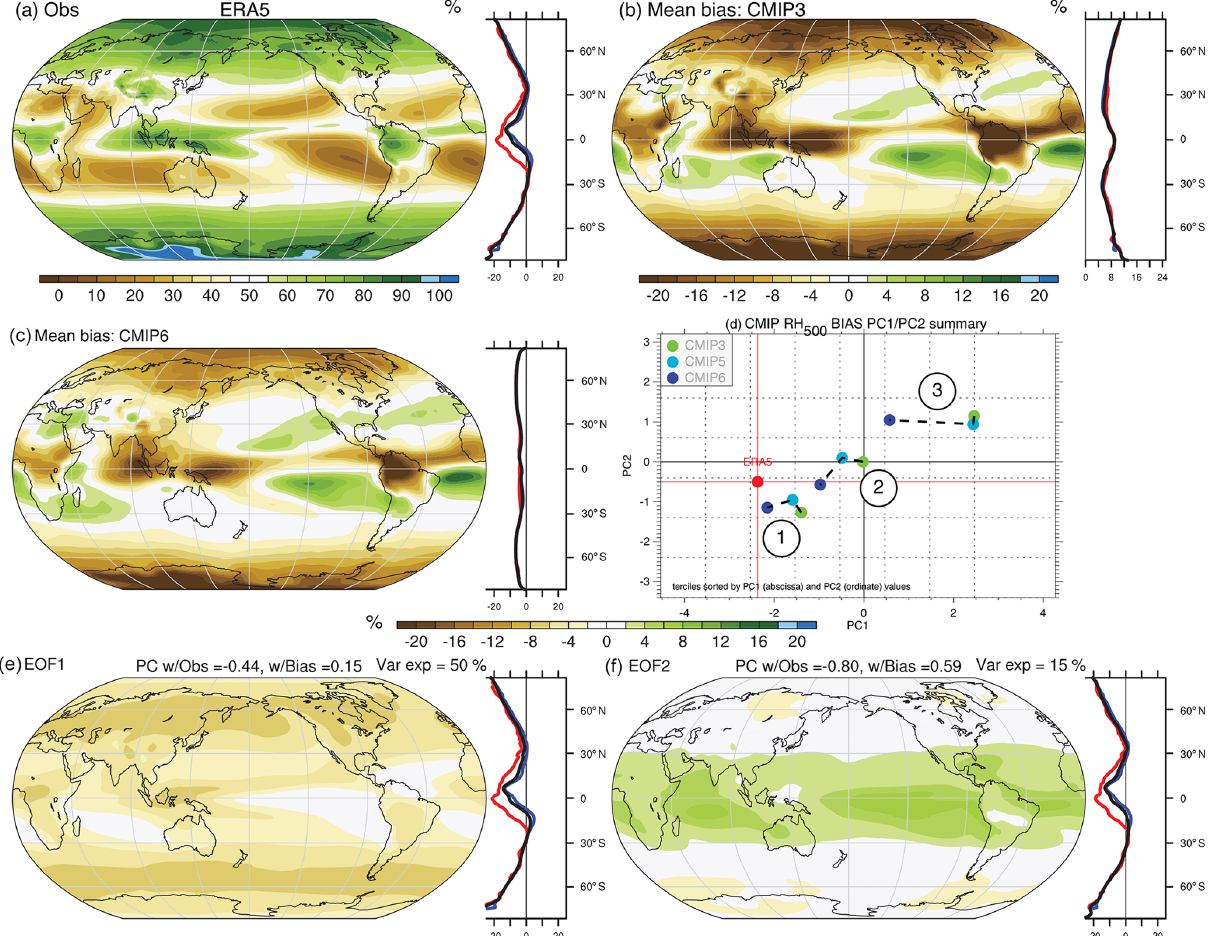
Figure 9. Analysis of the annual mean RH 500 bias in the combined historical CMIP3/5/6 archive including the following: (a) the observed estimate from ERA5; the mean bias in (b) CMIP3 and (c) CMIP6; and (d) the first two PCs of biases and their tercile averages across the CMIP archives and the associated (e) first and (f) second EOFs of biases. All units are percent (%), except for the PCs, which are unitless. Zonal means (right panels) include land (red), ocean (blue), and global